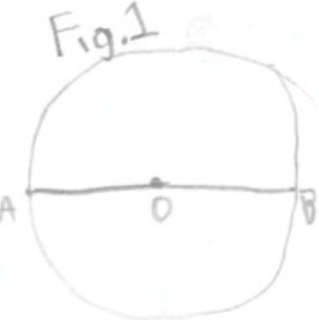
Figure 5. Picture proposed by